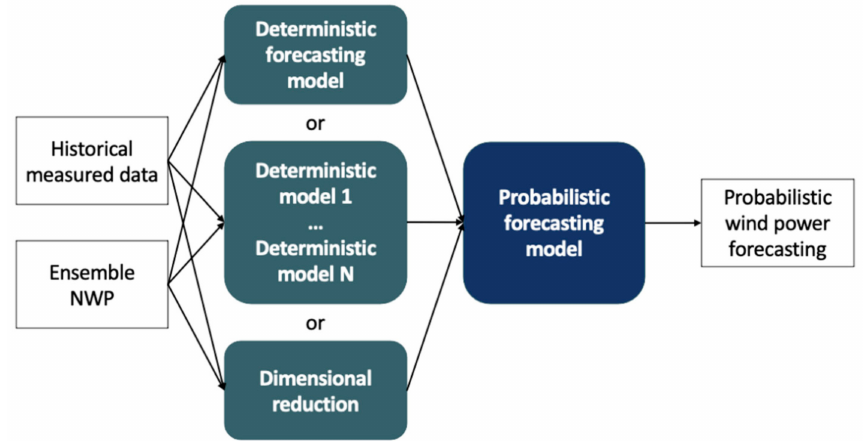
Figure 2. Schematic diagram of probabilistic approaches based on ensemble